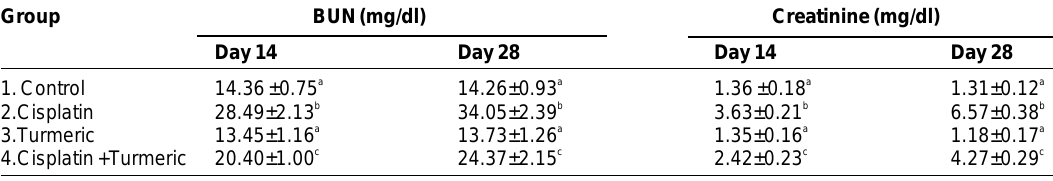
Values are Mean + SE (n = 6); One way ANOVA (SPSS Version 15) Table-2. Serum biomarkers of nephrotoxicity in different groups of Group